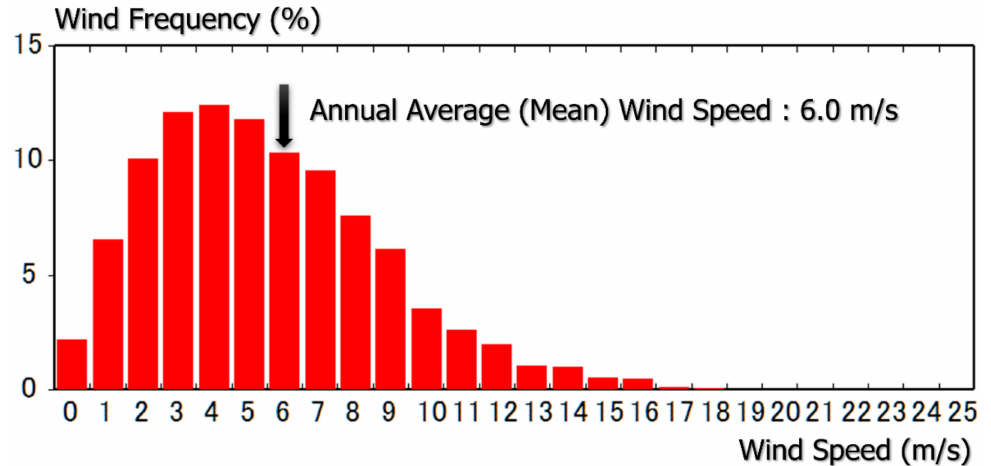
Figure 25. Annual wind speed distribution on for a 50 m-high virtual met